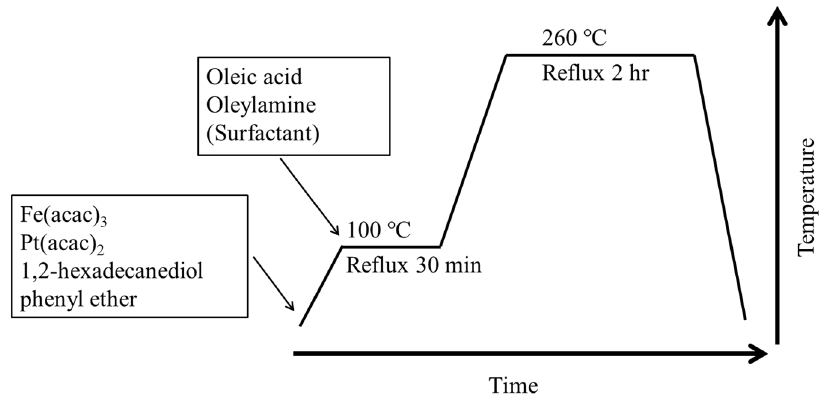
Figure 1. Flow chart of iron–platinum nanoparticles (FePt NPs) synthesis.